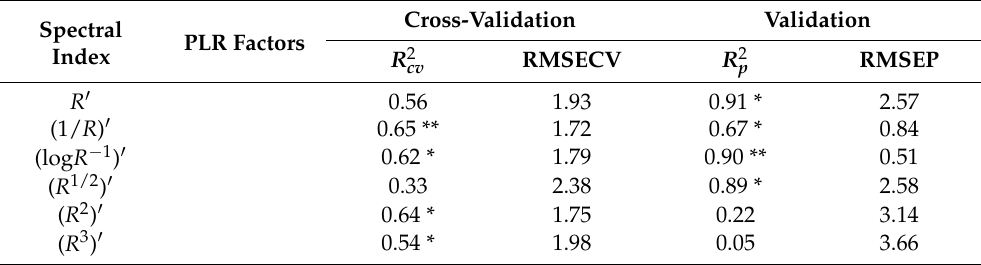
Table 9. Results of partial least squares regression analysis of first-derivate transformation and soil organic matter content.